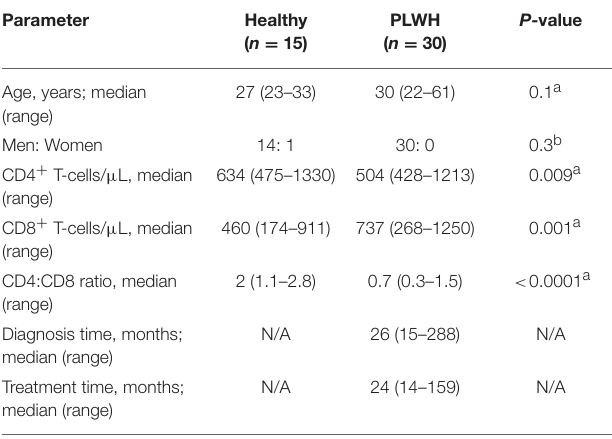
TABLE 1 | Characteristics of the study